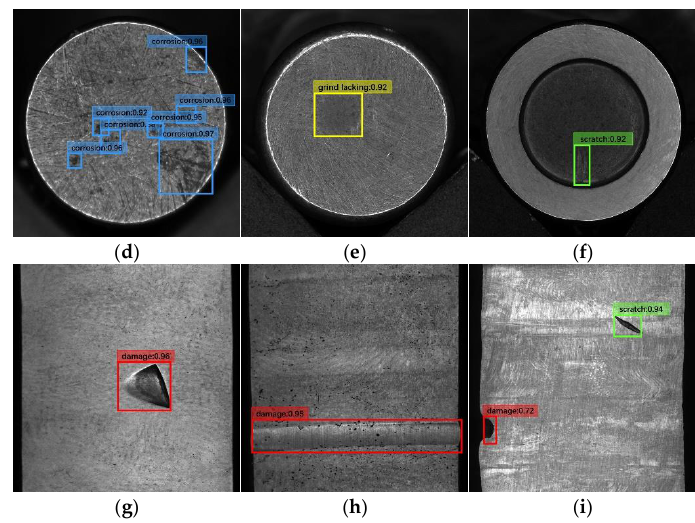
Figure 9. Defect detection results: (a) Corrosion and damage; (b) grind lacking and damage; (c,d) corrosion; (e) grind lacking; (f) scratch; (g,h) damage; (i) damage and scratch. The red box belongs to damage, the green box belongs to scratch, the yellow box belongs to grind lacking, and the blue box belongs to corrosion.